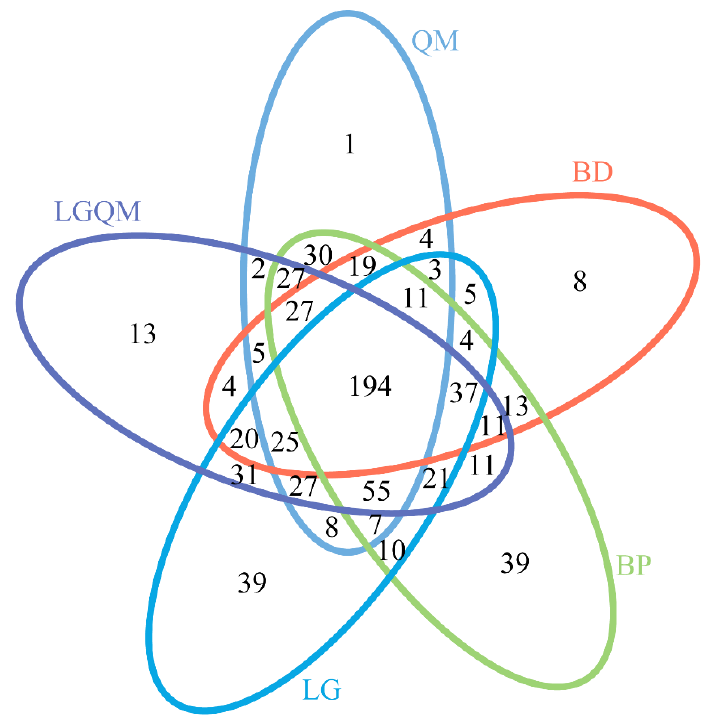
Figure 5. Venn diagram of shared and unique fungal OTUs among the vegetation types. BD, Betula dahurica ; BP, Betula platyphylla ; LG, Larix gmelinii ; LGQM, Q. mongolica and L. gmelinii mixed forest; QM, Quercus mongolica .